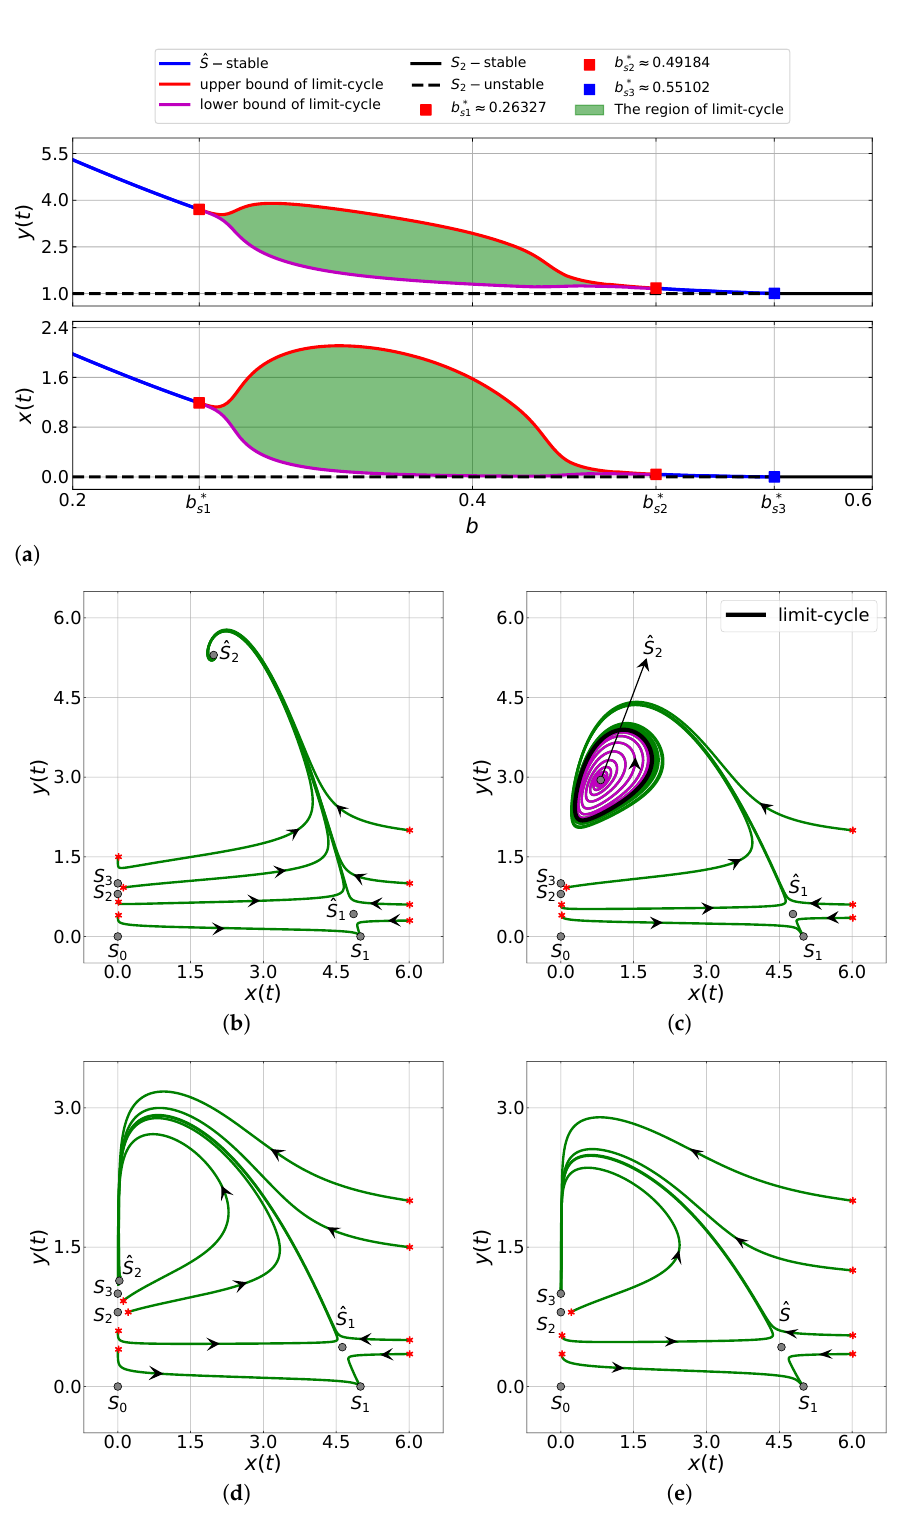
Figure 2. Dynamics of system (6) with parameter values (27) and α = 0.98. ( a ) Bifurcation diagram of system (6) driven by b for the case of strong Allee effect ( m = 0.4 > 0 ) . ( b – e ) Phase-portrait of system (6) with ( b ) b = 0.20, ( c ) b = 0.40, ( d ) b = 0.50, and ( e ) b = 0.60. The predator extinction point is always locally